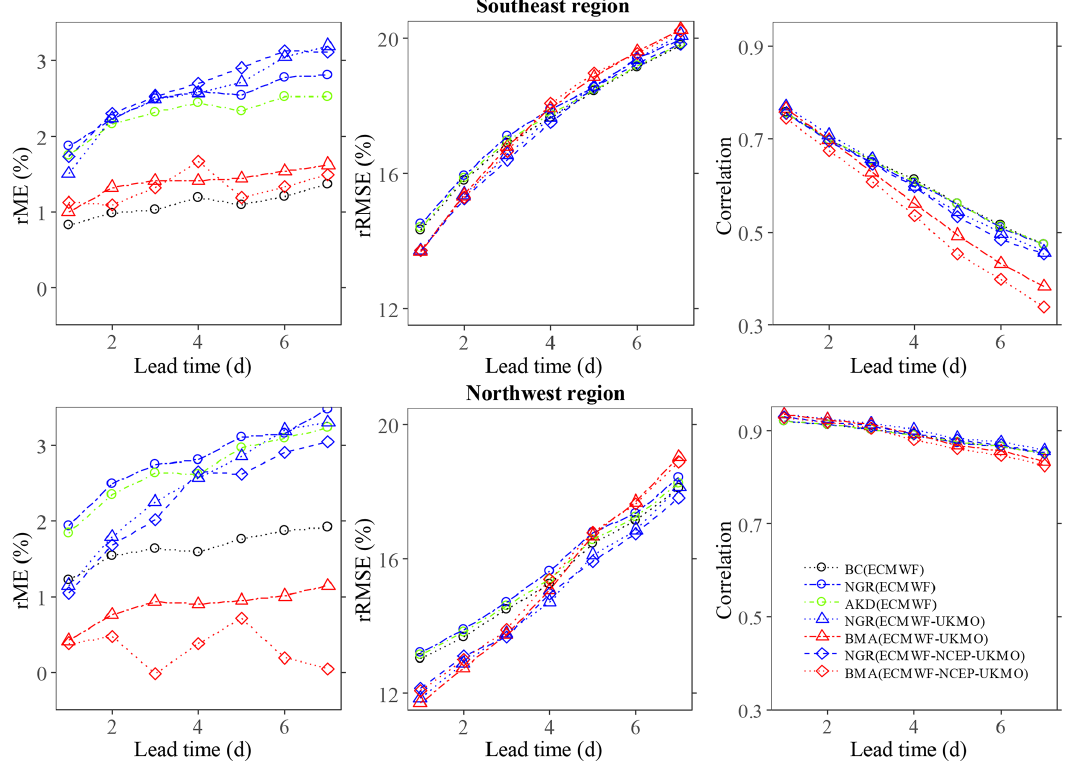
Figure 2. Relative mean error (rME), relative root-mean-square error (rRMSE), and correlation values considering daily forecasts for differ- ent lead times over the southeast and northwest regions.